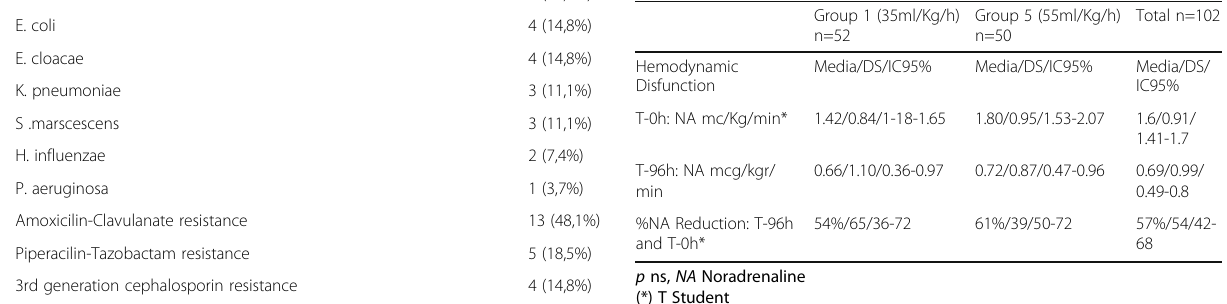
Table 90 (abstract A293). Isolations and resistances Table 91 (abstract A294). Noradrenaline reduction at 96 h septic shock onset